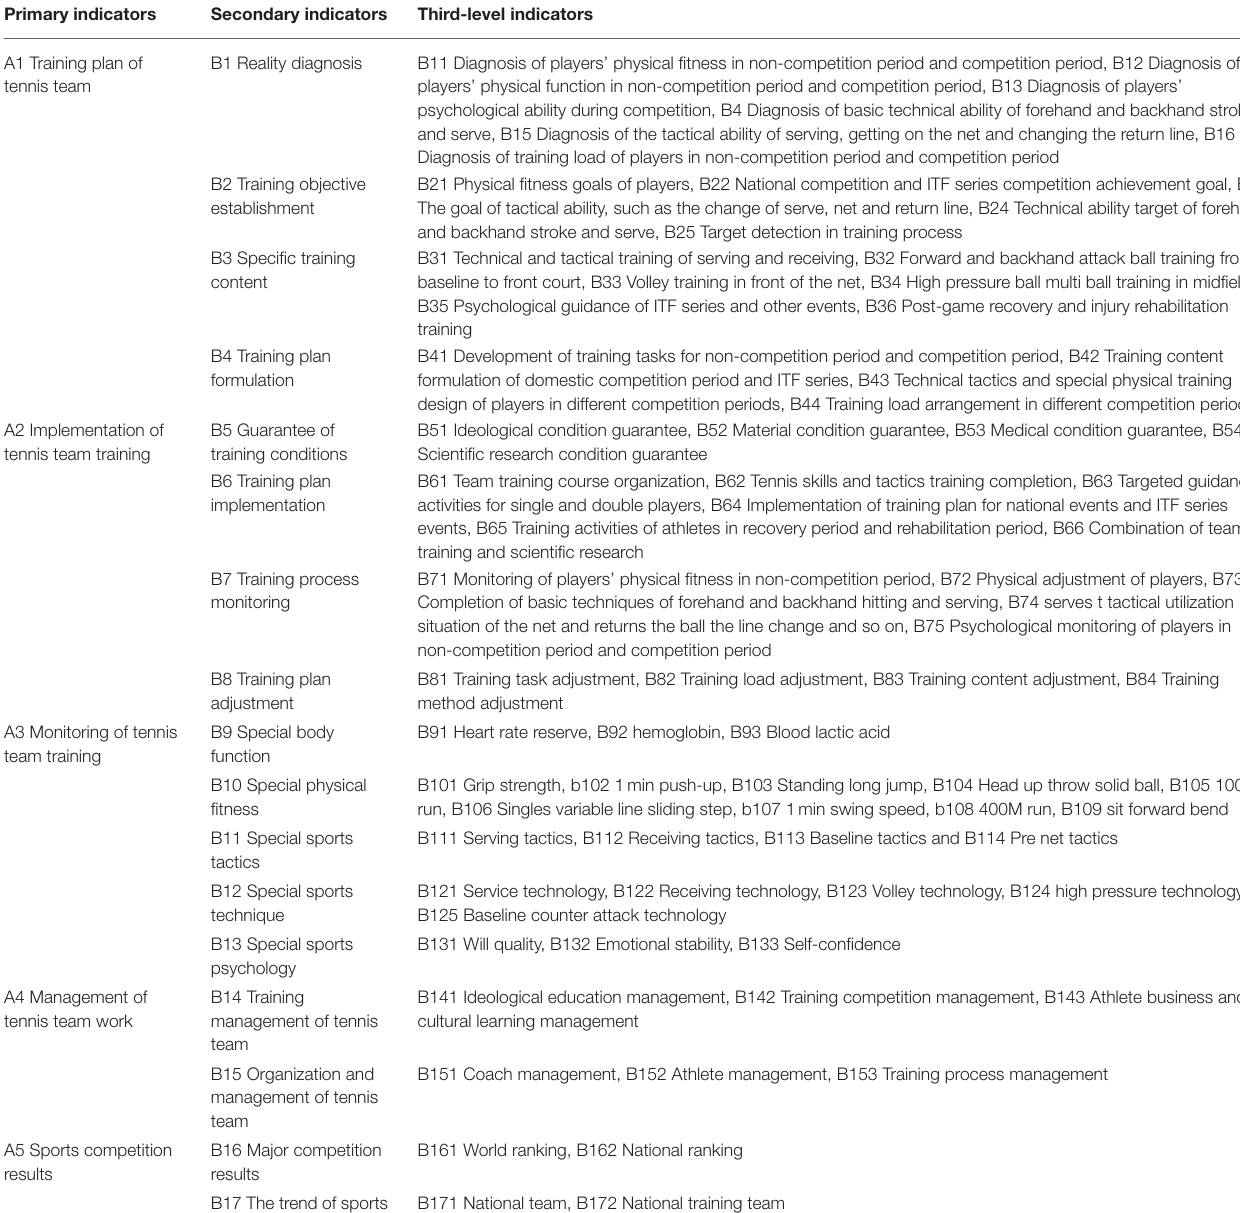
TABLE 13 | Quality evaluation index list of high-level tennis team trainers. Primary